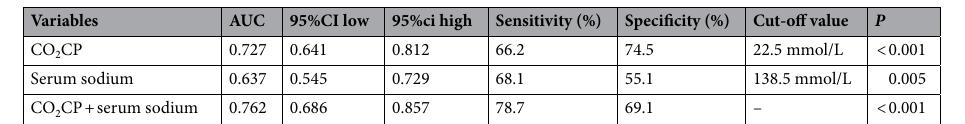
Table 2. ROC curves analysis for adverse events in